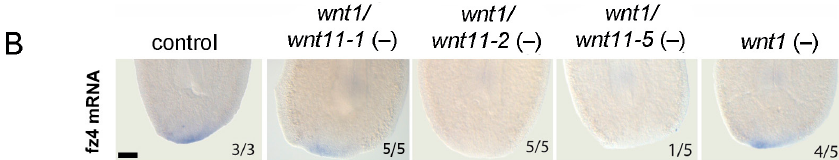
Figure 2. Cooperation of posterior wnts to specify posterior identity during regeneration. ( A ) Quantification of the different phenotypes observed after silencing each posterior wnt alone and Smed-wnt1 in combination with the other posterior wnts . Two new phenotypes appeared after silencing Smed-wnt1/Smed-wnt11-1 ( A ′ ) and Smed-wnt1/Smed-wnt11-5 ( B ′ ), both of which show a “tailless” morphology next to the differentiation of a second pharynx alongside the original one. Animals were fixed at 20 days of regeneration. (The number of animals analyzed for single RNAi was n = 4–10 and for double n = 7–20.). A ′ , B ′ images correspond to confocal z-projections; and ( B ) In situ hybridization analysis of the expression of posterior markers in 3-day regenerating animals in which Smed-wnt1 was silenced together with the other posterior wnts . (The number of animals analyzed for each condition was n = 3–5.). Anterior is left/up, posterior is right/down in A ′ , B ′ ; anterior is up, posterior is down in ( B ). Scale bar: 100 µm ( A , B ). 2.3. Silencing of All Posterior Wnts Together Is Insufficient to Transform Posterior Identity into Anterior during Homeostasis